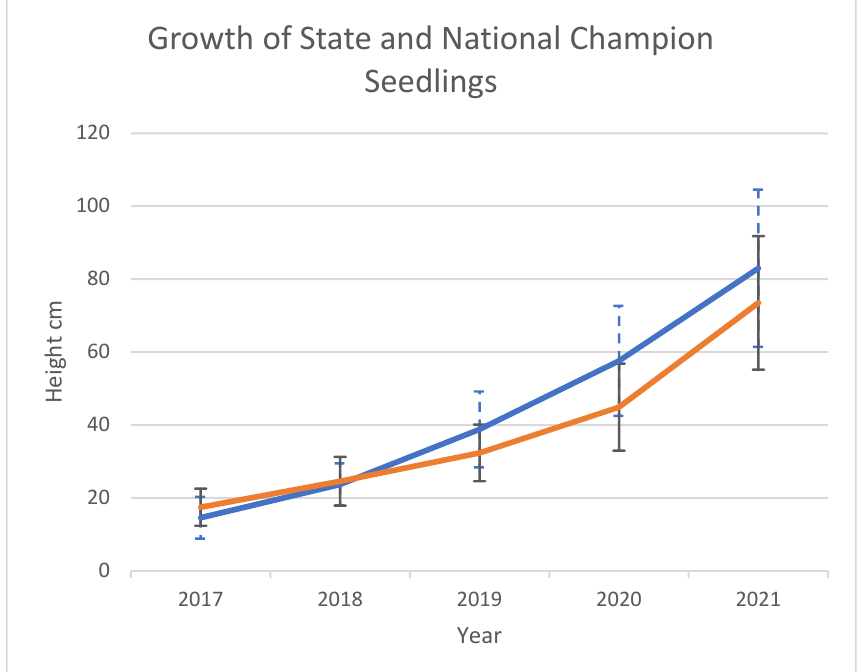
Figure 4. Growth of 2016 seedlings from the National Champion A. glabra (orange line) and the Ohio State Champion (blue line). Standard deviations are shown by solid lines for the National Champion seedlings and dashed lines for the Ohio State Champion seedlings.